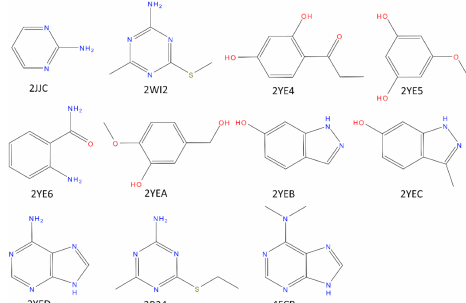
Figure 1. Structure of the crystal ligands bound to N-HSP90 in the structures used for the present work. All the ligands have a molecular weight below 175 Da. Only for complexes 2WIC, 2YE4, and 2YE6 a ffi nity data was reported on literature (2WI2IC 50 = 350 µ M; 2YE4, IC 50 = 570 µ M; 2YE6, IC 50 = 4000 µ M; 3B24, K d = 42 µ M).